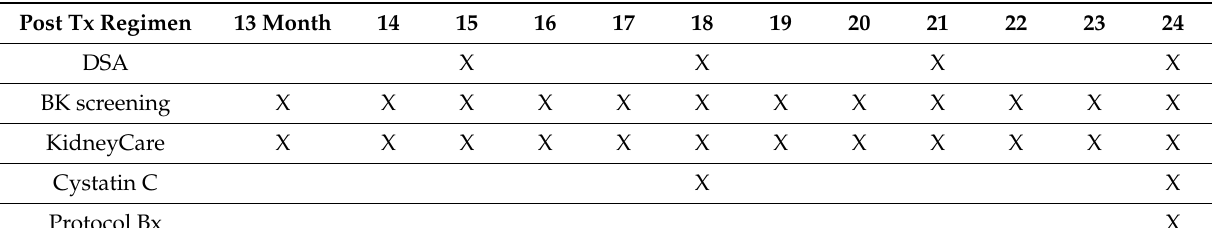
Table 4. Year Two-Continue Immunosuppressant Regimen from Month